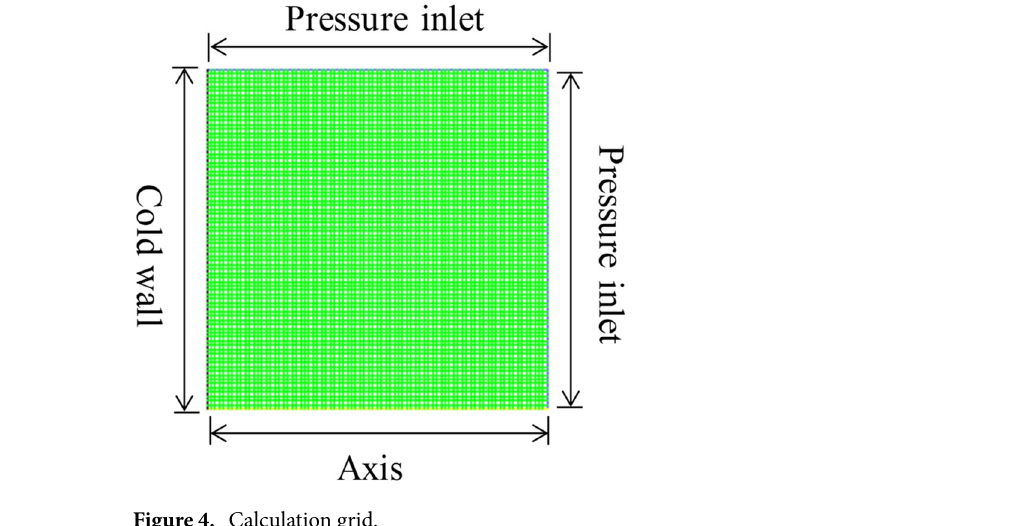
Figure 4. Calculation grid.